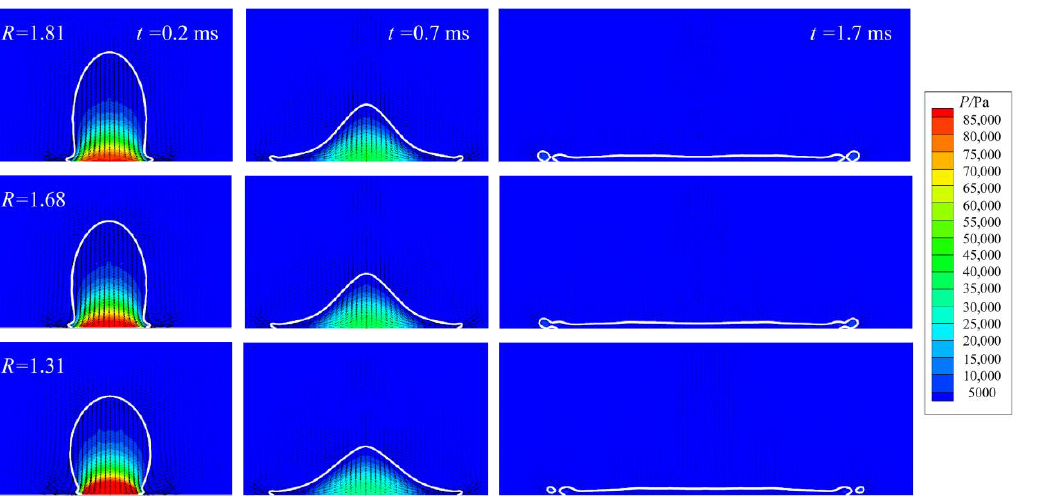
Figure 18. Pressure evolution and streamline distribution during early stages of spreading.